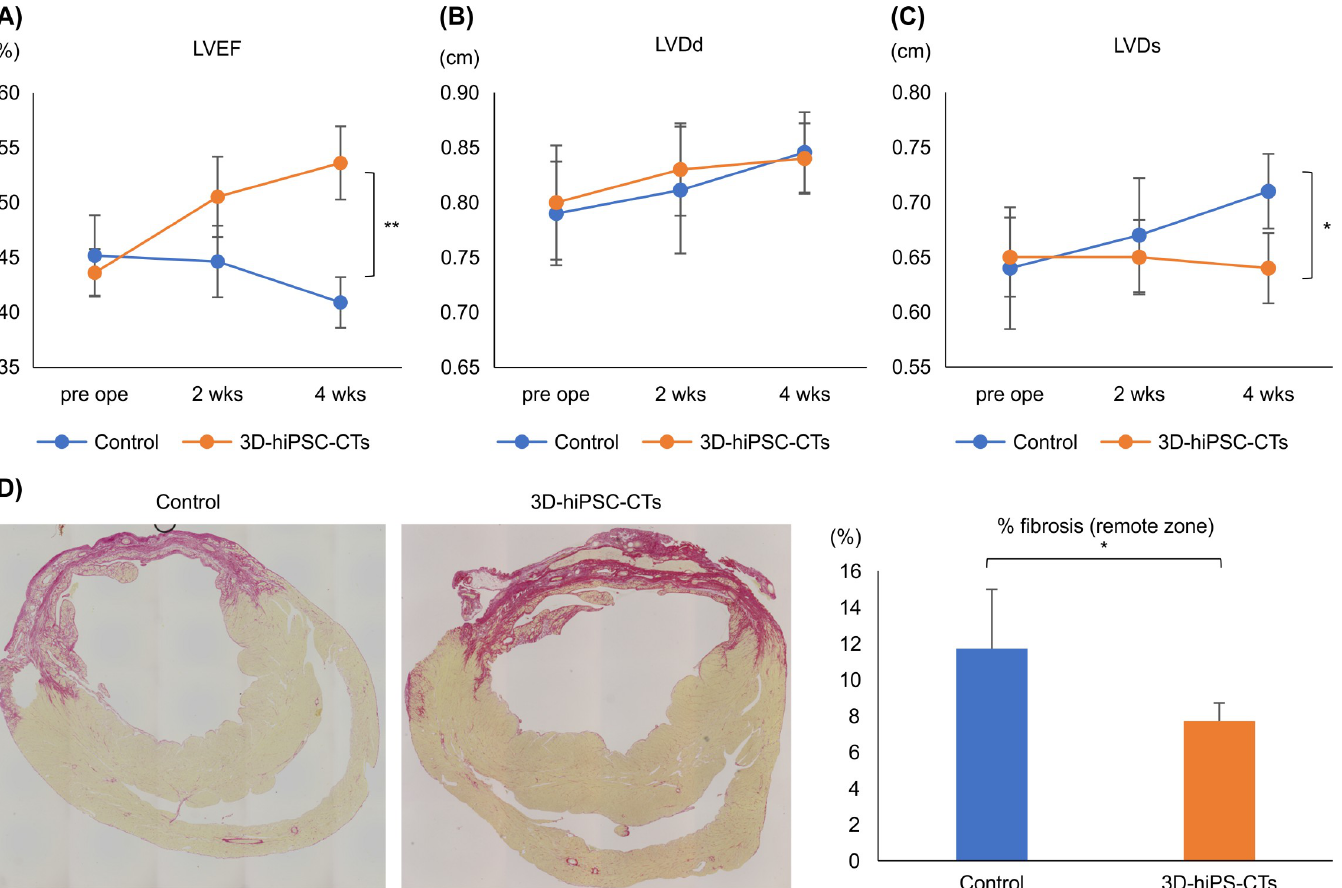
Fig 3. The three-dimensional human induced pluripotent cell-derived cardiac tissue (3D-hiPSC-CT) improved cardiac function in the myocardial infarction rat model. (A–C) Results of B-mode echocardiogram: left ventricular ejection fraction (LVEF), end-diastolic diameter (LVDd), and end-systolic diameter (LVDs); � P < 0.01, �� P < 0.001. (D) Fibrosis area at the remote zone in myocardial infarction hearts 4 weeks after transplantation. Sections were assessed by Picro Sirius Red staining. � P < 0.01.